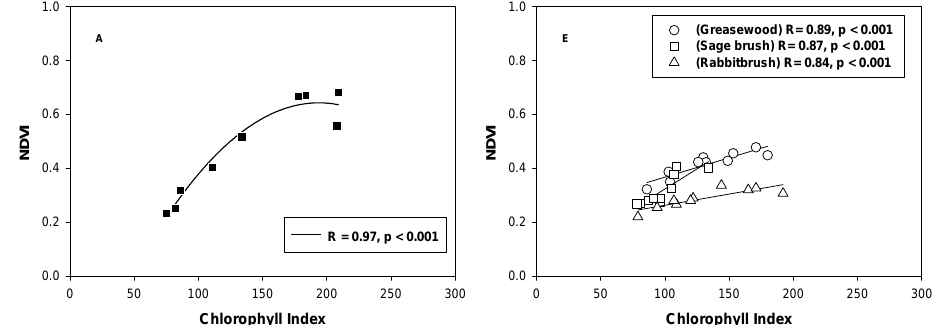
Figure 6. Comparison of plant measurements relationships with SKR-1800 NDVI values between the Snake Valley 1 site (left panel: A, B, C and D) and the Spring Valley 1 site (right panel: E, F, G and